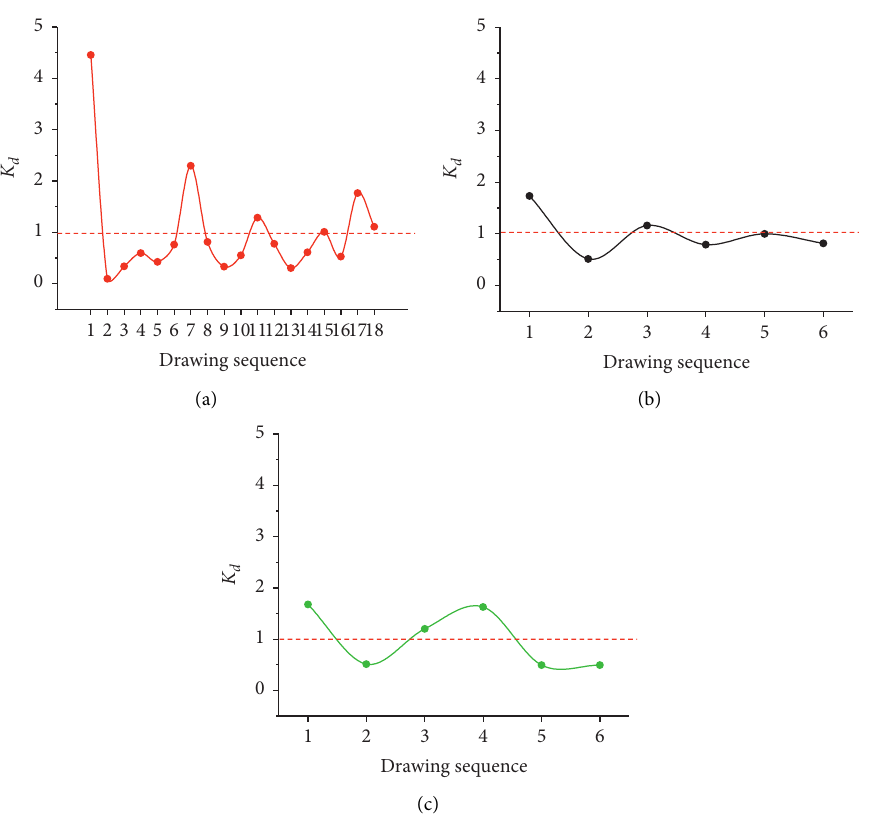
Figure 10: The variation of K d under (a) SOSCT, (b) MOSCT, and (c) ICGCT.